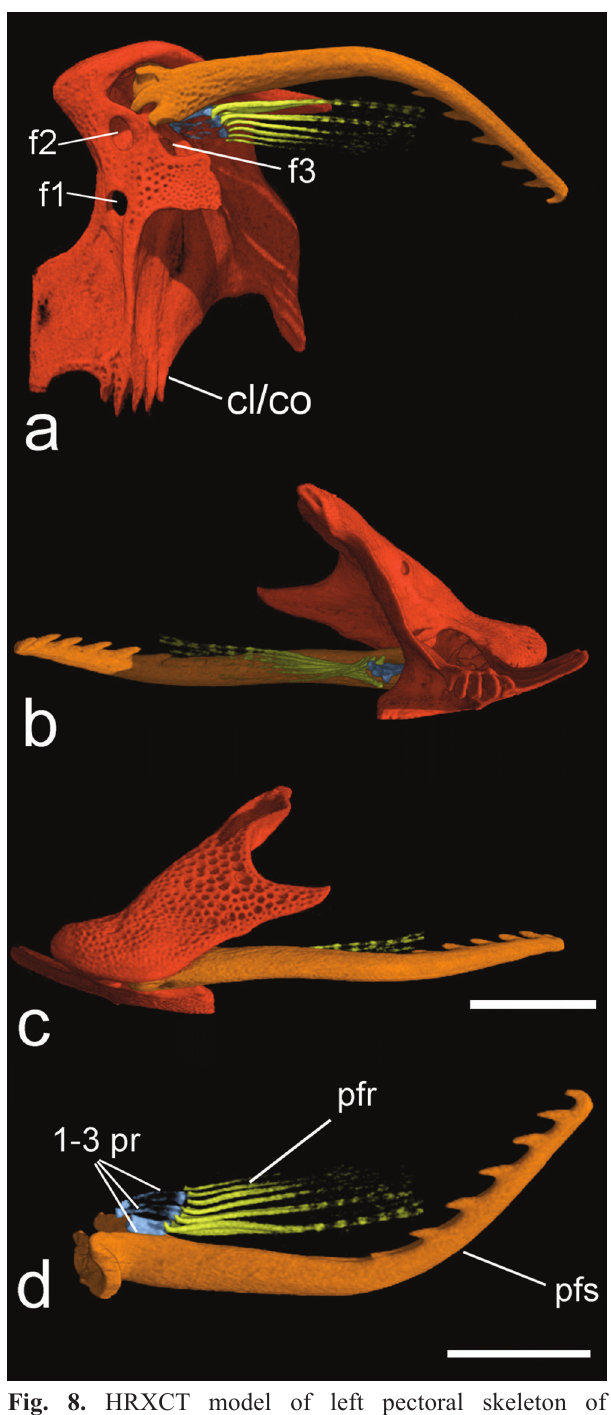
Fig. 8. HRXCT model of left pectoral skeleton of Hoplomyzon cardosoi , MCNG 375, holotype, 18.5 mm SL. a. ventral view (anterior towards left). b. medial view (anterior towards right). c. lateral view (anterior towards left). d. Dorsal view (anterior towards bottom). 1-3 pr: pectoral-fin proximal radials; cl/co: fused cleithrum-scapulocoracoid; f1: Cleithral arrector dorsalis foramen; f2: Cleithral arrector superficialis foramen; f3: Scapulocoracoidal abdutor superficialis foramen; pfr: pectoral-fin rays; pfs: pectoral-fin spine. Scale bars = 1 mm.